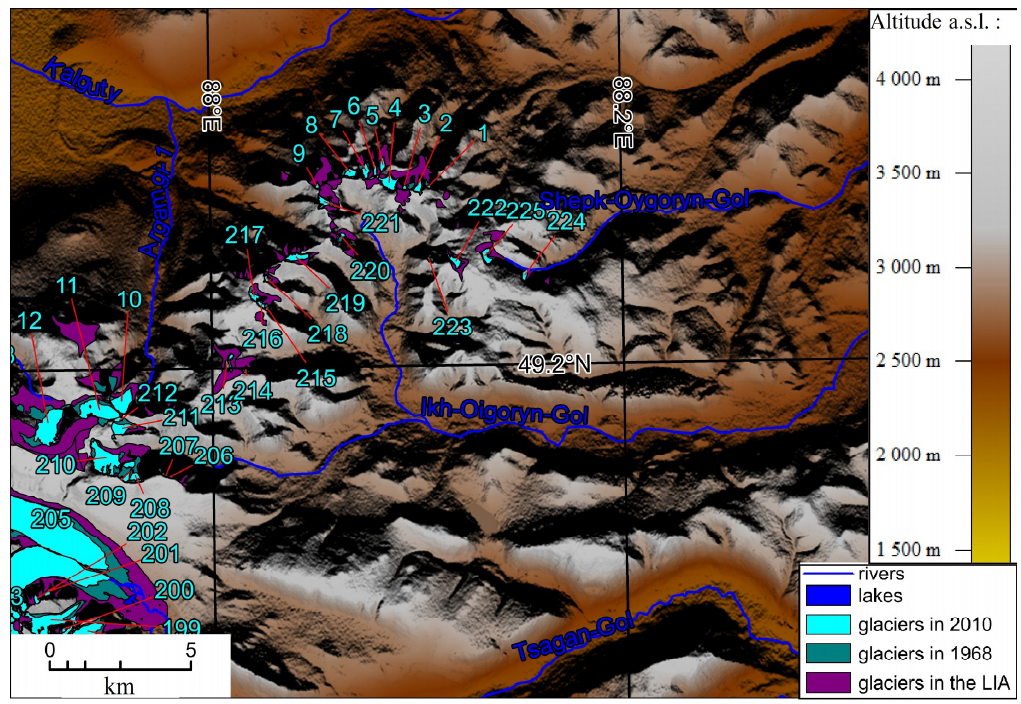
Figure 12. Glacial shrinkage after the LIA peak in the north‑east of Tavan Bogd.